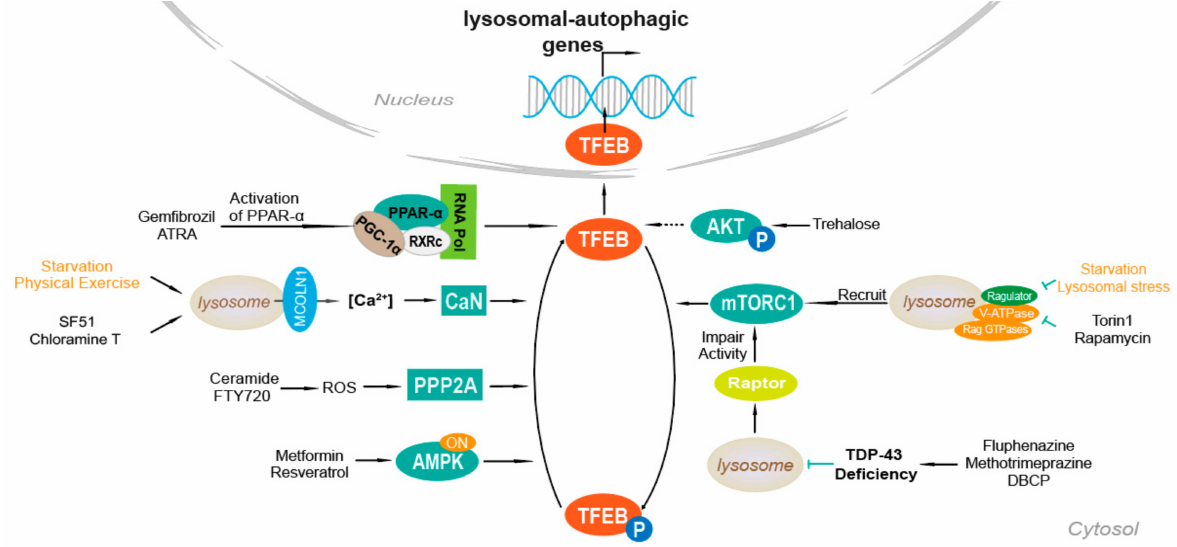
Figure 1. Schematic of mechanisms of TFEB agonists. The schematic shows the model of Ca 2+ mediated regulation of TFEB, the model of lysosomal sensing and lysosome-to-nucleus signaling by TFEB and mTOR as well as the model of PP2A stimulating regulation of TFEB. AKT, loss of FLCN modulates the autophagy-lysosomal pathway via TFEB. PPAR- α -RXR α -PGC-1 α complex and knocking down TDP-43 can promote the transcriptional activation of TFEB. Abbreviation: CaN, Calcineurin; AKT, protein kinase